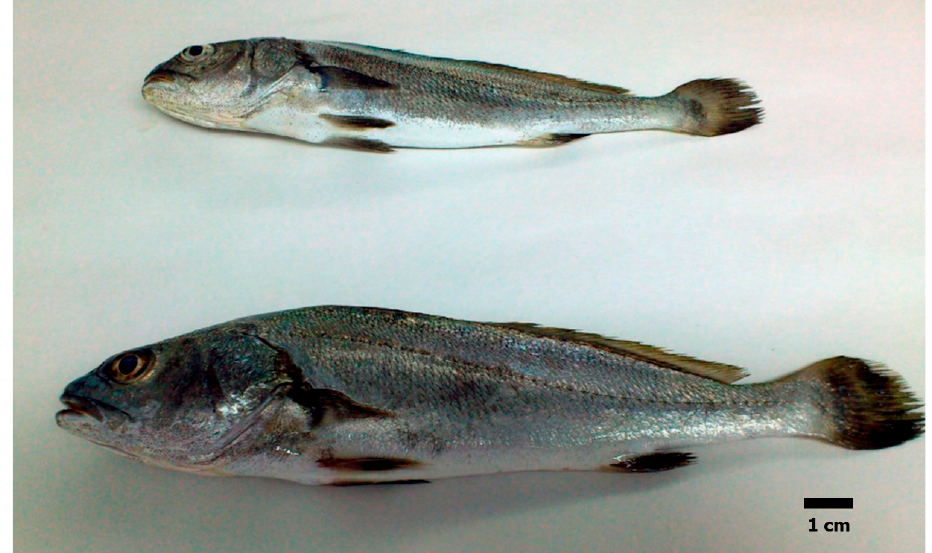
Figure 1. Juvenile meagre naturally infected by V. tapetis . No macroscopic external or internal signs of disease were apparent.